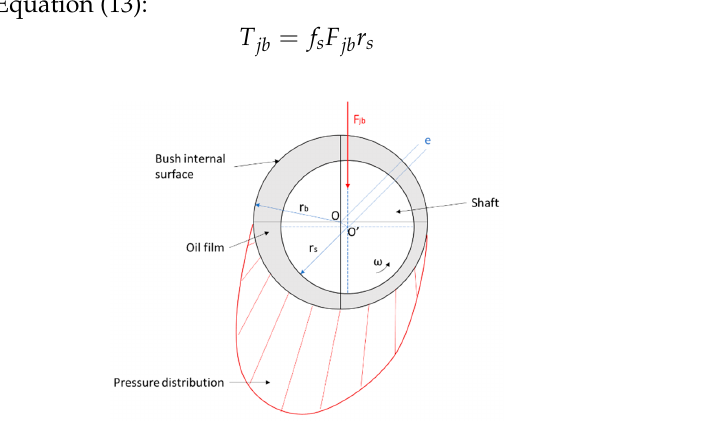
Figure 4. Qualitative pressure distribution in the journal bearing (gear shaft-bushing blocks gap).